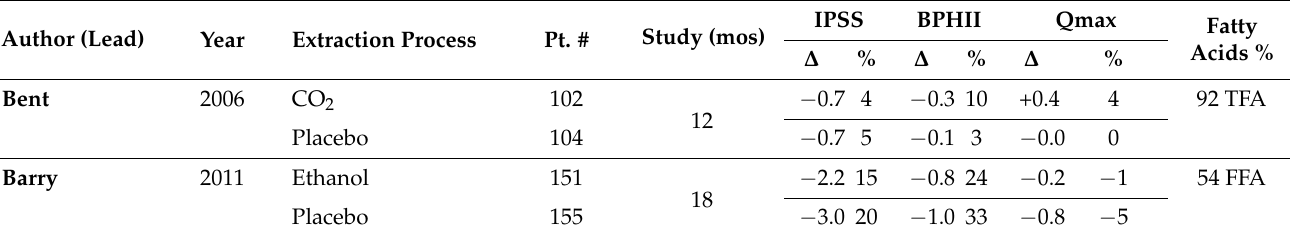
Table 1. The Bent (STEP) and Barry (CAMUS) studies are the preeminent placebo-controlled trials of LSESr vs. LUTS with negative